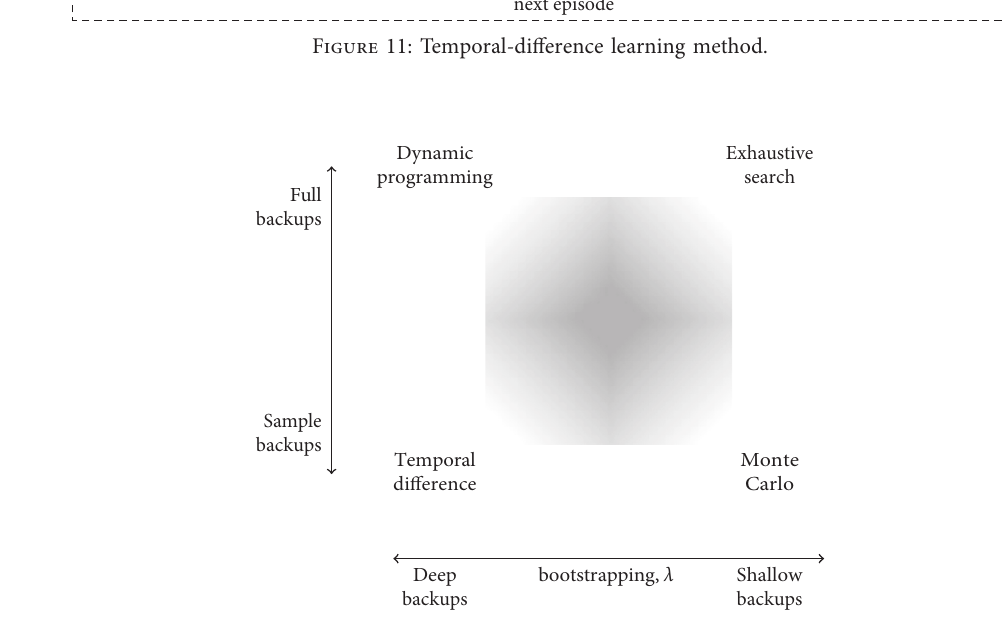
Figure 12: Unified view of model-free prediction techniques.